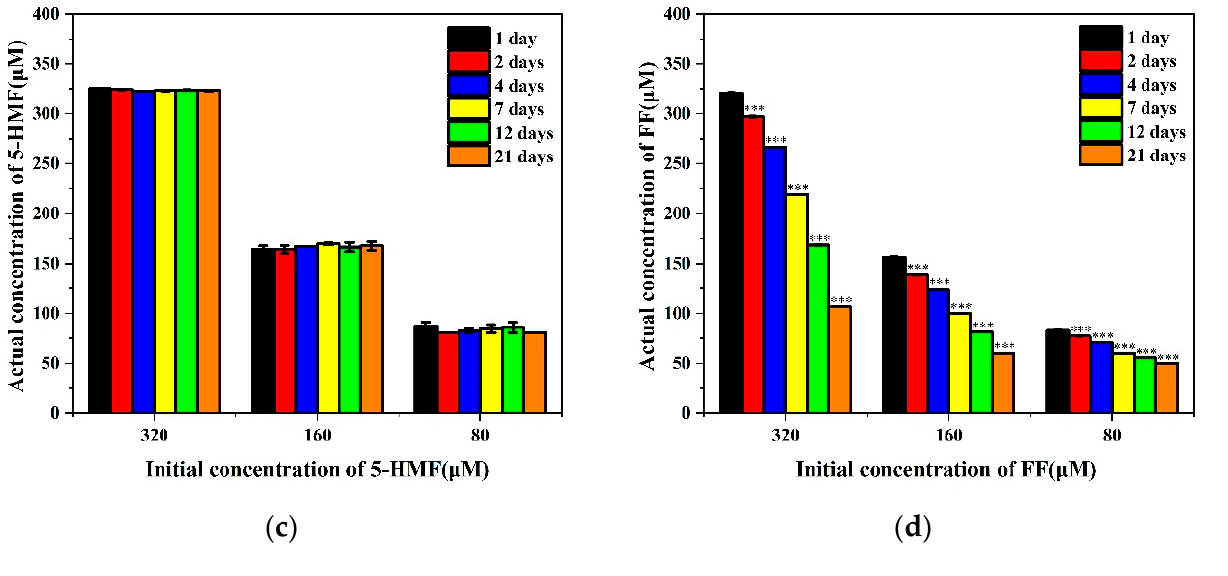
Figure 1. Concentration changes in 5-HMF and FF detected by HPLC. ( a ) Standard curve of 5-HMF; ( b ) Standard curve of FF; ( c ) Variation of 5-HMF at different concentrations with time; ( d ) Variation of FF at different concentrations with time. *** p < 0.001 vs. 1 day.